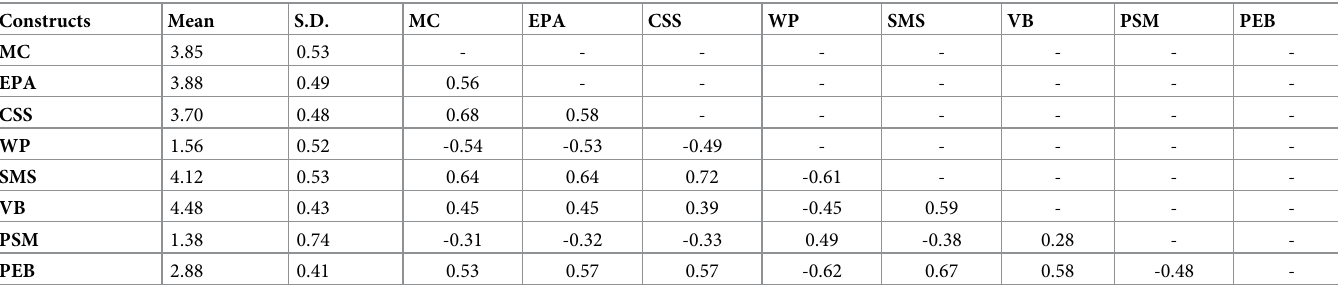
Table 3. Means, standard deviation and correlations.